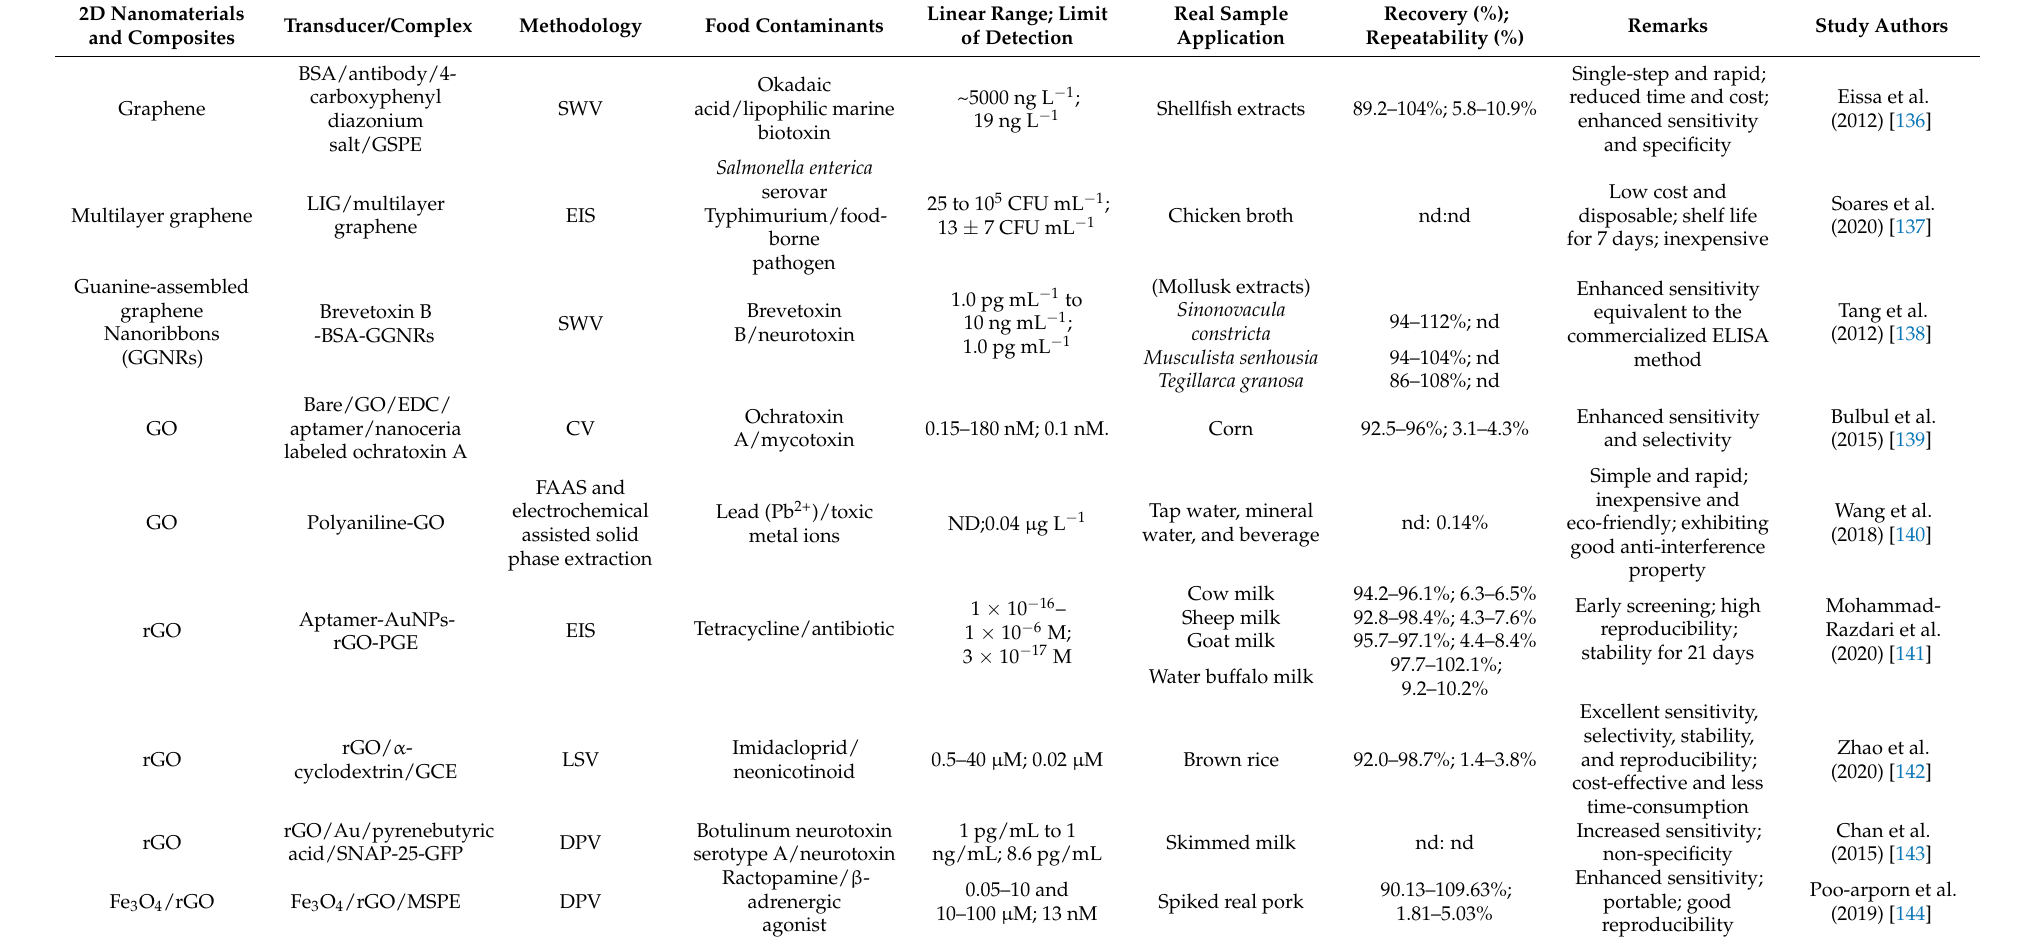
Table 1. Contribution of 2D nanomaterials in electrochemical biosensors in sensing food